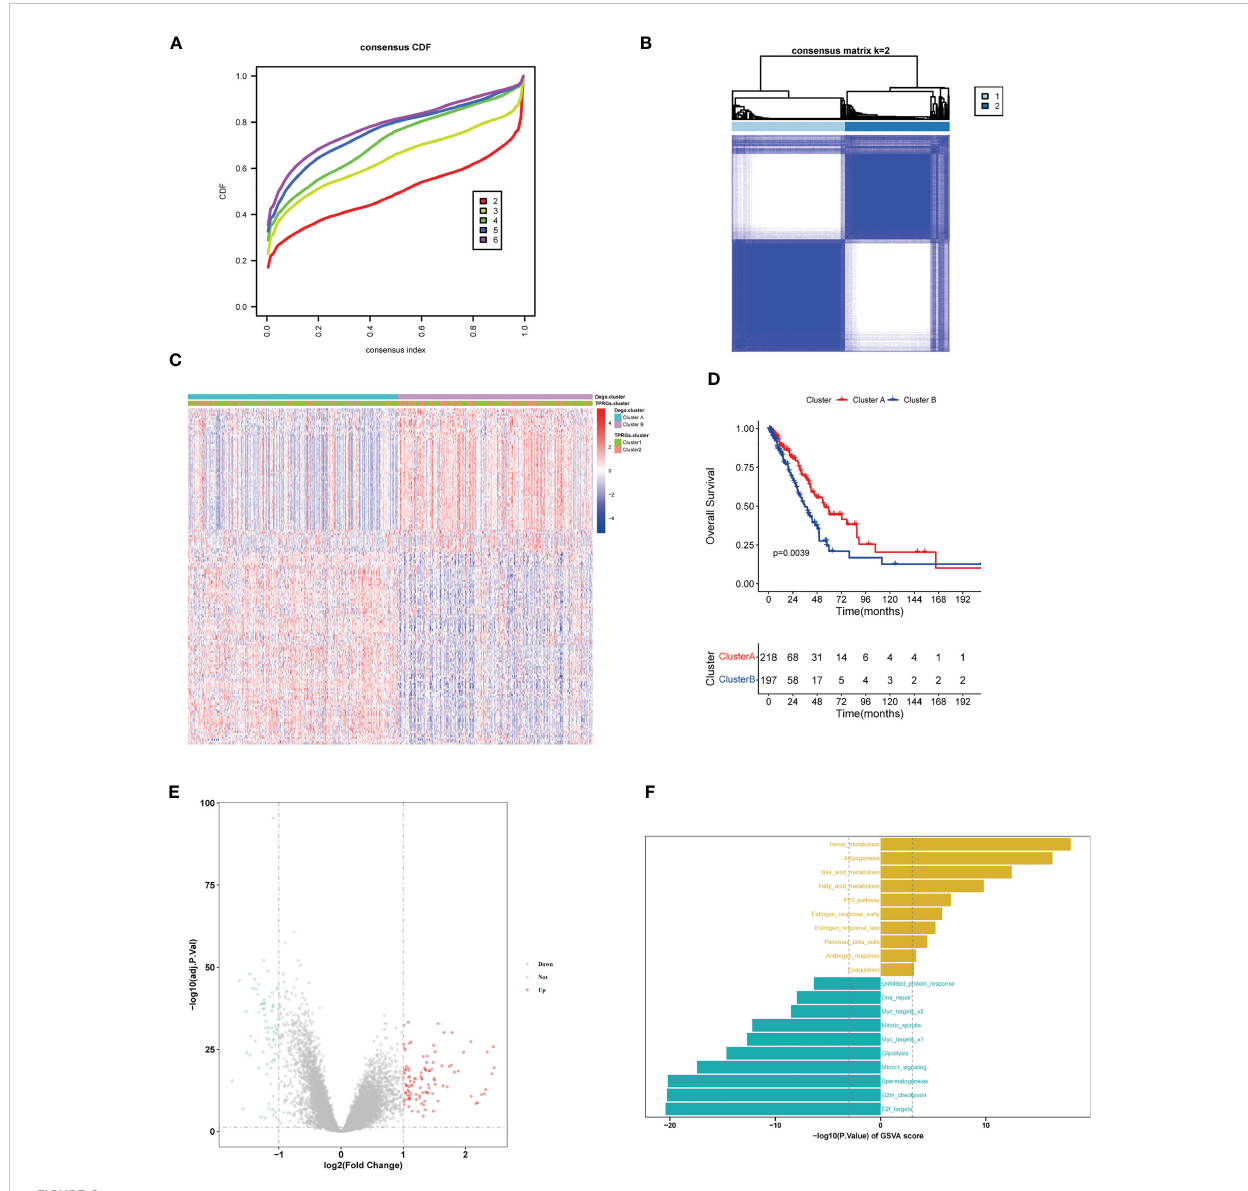
FIGURE 6 LUAD clustering (cluster A and cluster B ) based on differentially expressed genes (DEGs) between clusters 1 and 2. (A) Identi fi cation of consensus clusters (clusters A and B ) based on DEGs between cluster 1 and cluster 2. (B) Clustering heatmap of clusters (A, B) Consensus k=2. (C) Heatmap shows the DEGs expression pro fi les in the different LUAD clusters (including cluster 1, cluster 2, cluster A and cluster B ). (D) Kaplan – Meier survival curves of overall survival in the clusters (A, B, E) Volcano plot for DEGs analysis between clusters (A, B, F) Gene Set Variation Analysis of T cell proliferation-related regulator genes in clusters (A, B)